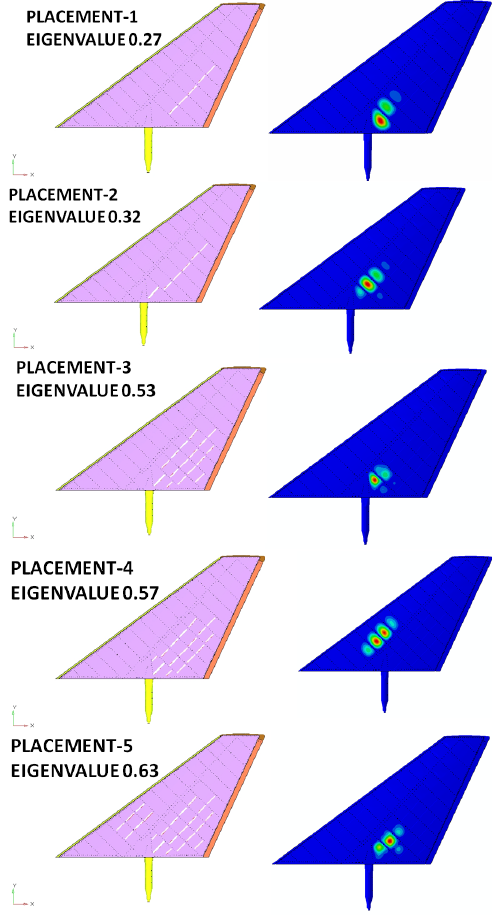
Figure 6: Placement of Reinforcements to Increase Critical Buckling Load